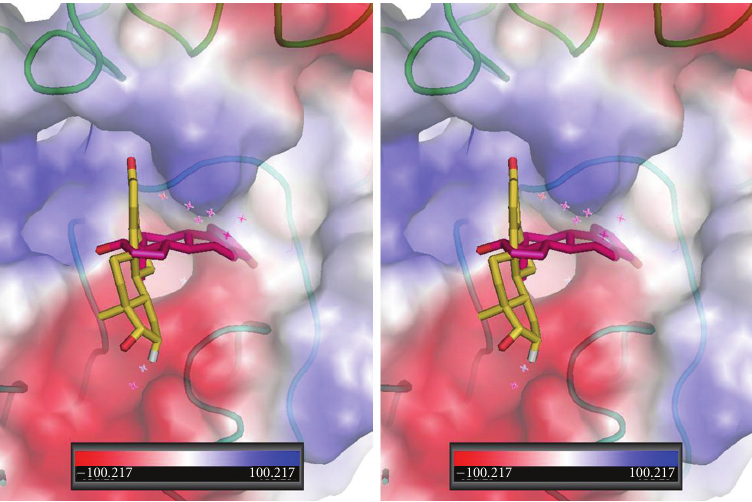
Figure 12: Stereoview of α v β 3 integrin RGD showing two orientations for estradiol (Ca2, (violet) and Ca2 (gold)).